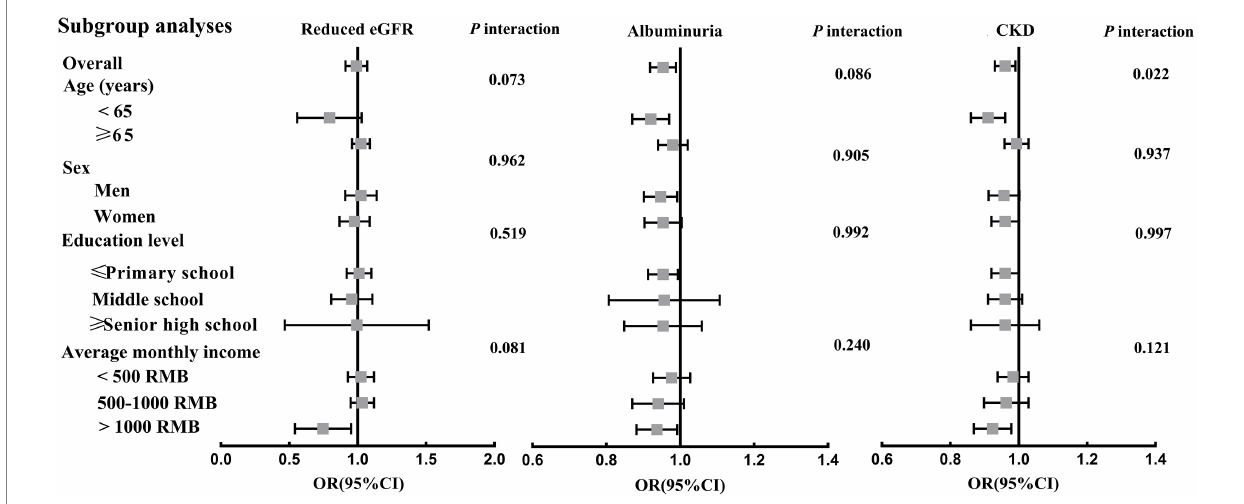
FIGURE 3 Associations between per 50 g/day increment in total beans intake and reduced eGFR, albuminuria and CKD prevalence in subgroup analyses. Adjusted for age, gender, education level, averaged monthly income, current smoker, current drinker, physical activity, body mass index, red meat (g/day), white meat (g/day), fish (g/day), egg (g/day), milk (g/day), vegetable (g/d) and fruit (g/d), T2DM, hypertension, dyslipidemia and